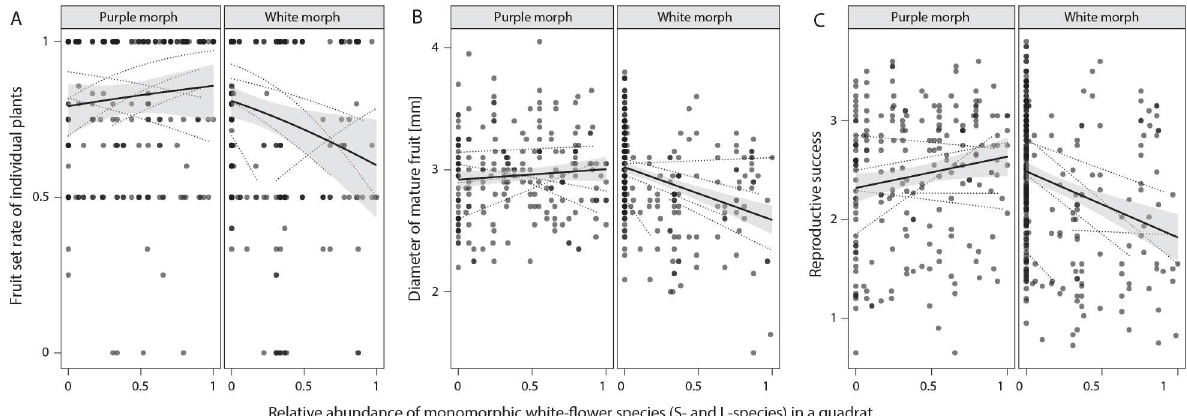
Fig 6. Fruit set rate (a), the diameter of mature fruit (b), and the female reproductive success(c) of two color morphs of M- species as a function of the relative abundance of monomorphic white-flower species (S- and L-species) in a quadrat. Dotted lines are regressionline for each populationused. Bold regressionlines are estimated by regressionfor all data points without any regard to populations. The shadedarea indicates the confidence interval of the regressionlines.